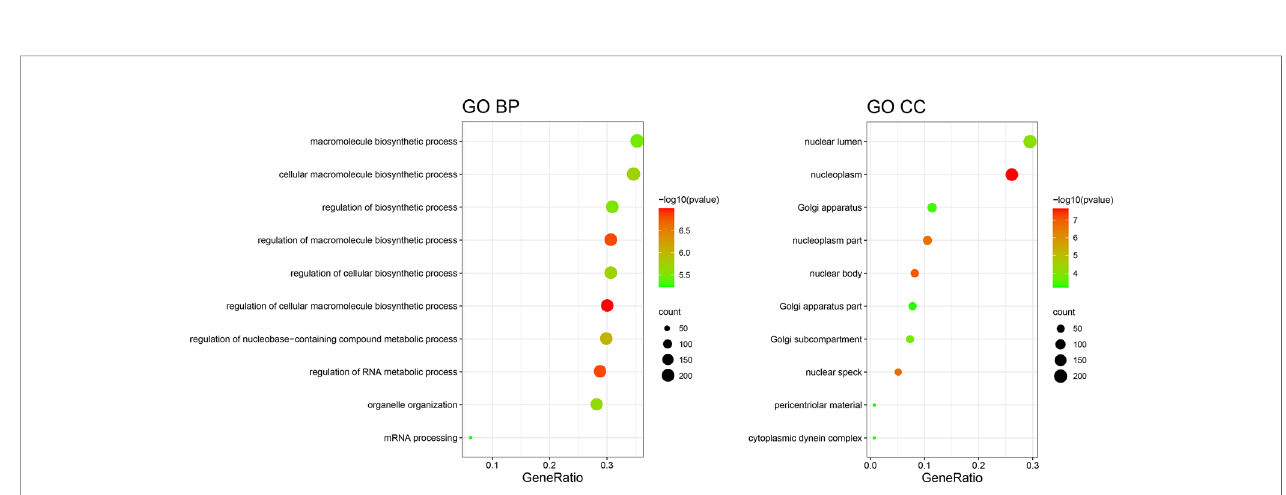
FIGURE 3 | GO term enrichment results.